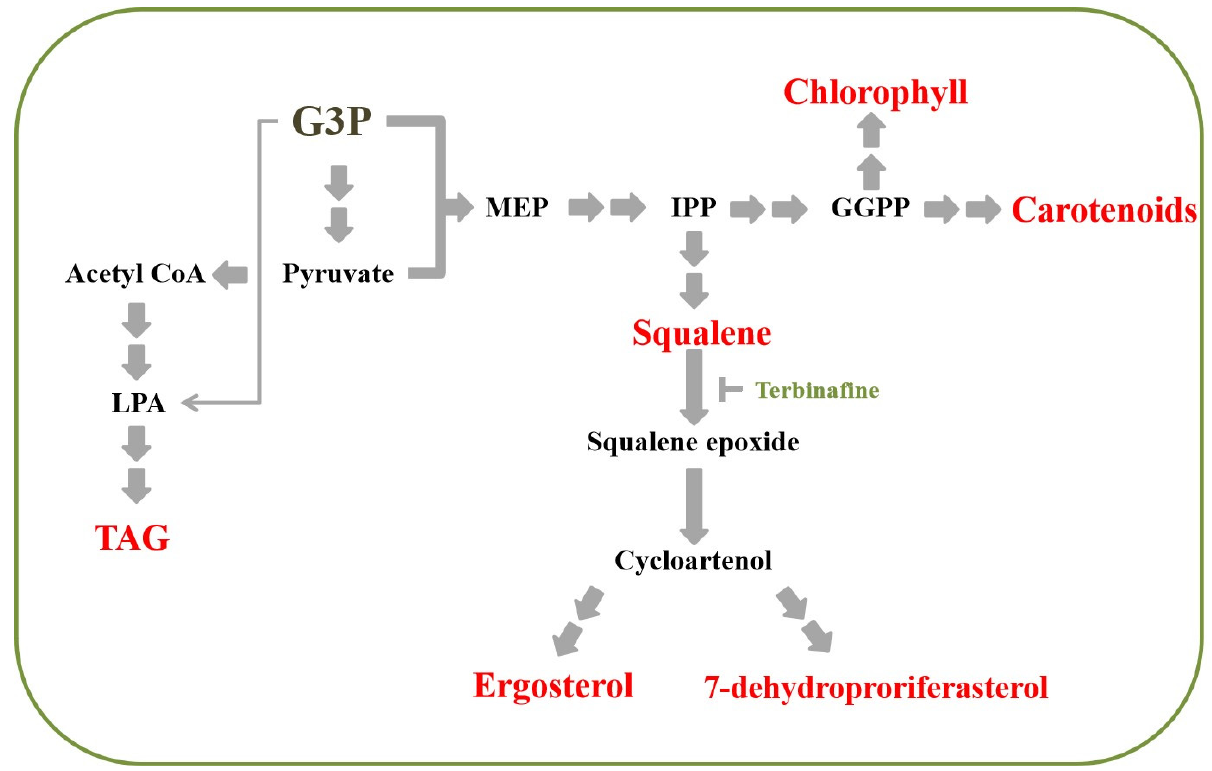
Figure 1. Simplified pathways for sterol, pigment, and triacylglycerol synthesis (G3P; glycerol-3-phosphate; GGPP: geranylgeranyl pyrophosphate; IPP: isopentenyl diphosphate; LPA: lysophosphatidic acid; MEP: 2-C-methyl-d-erythritol 4-phosphate; TAG: triacylglycerol).